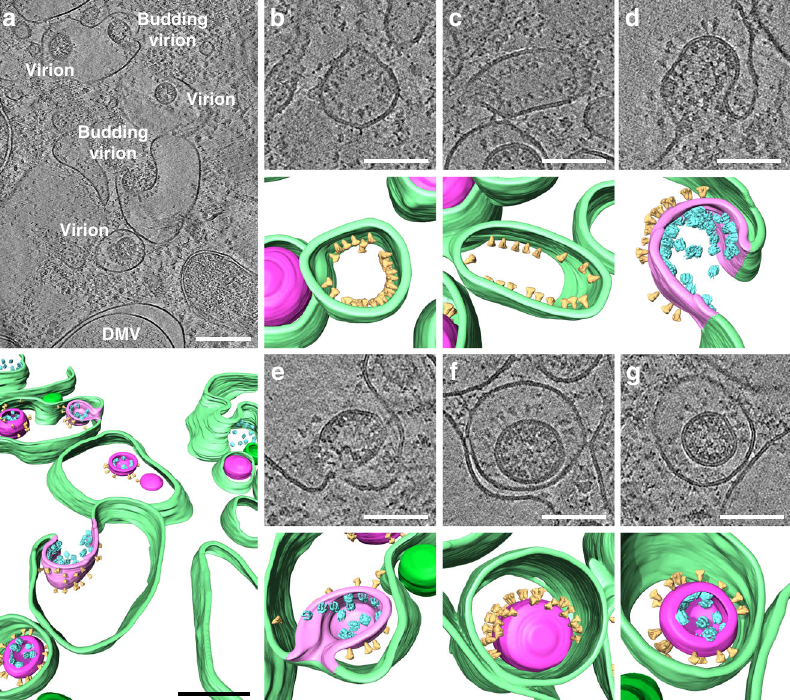
Fig. 3 SARS-CoV-2 virion budding and assembly at the ERGIC membrane. Different budding events captured in two tomograms (Supplementary Fig. 6 and Supplementary Movies 2 and 3) of VeroE6 cells infected with SARS-CoV-2 at 16 hpi. A 3D volume rendering is shown for each area with cellular and viral membranes in green and magenta, respectively. S (yellow) and vRNPs (cyan) are represented as subtomogram averages. The S and vRNP locations correspond to the location in the tomogram, vRNP orientations were randomized. A non-local means fi lter was applied, and 20 slices were averaged. a Overview of budding events at the ERGIC membrane and intracellular released virions inside the ERGIC lumen are indicated. b , c Accumulated S at the lumenal side of the ERGIC membrane. d , e Early virion budding stage with S and vRNPs accumulated at the lumenal and cytosolic ERGIC membrane, respectively. f Assembled viron in the ERGIC lumen in close proximity to the membrane, showing a polarized distribution of S. g Assembled virion further away from the membrane with redistributed S. Scale bars: a 200 nm, b – g 100